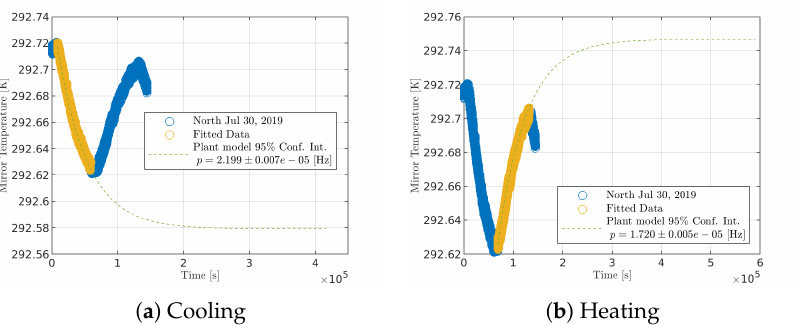
Figure 9. Single-pole plant modeling for mirror temperature response to a step input of the laser power representing unlock and subsequent lock acquisition. The modeled plant was used to determine a error offset for the unlock condition